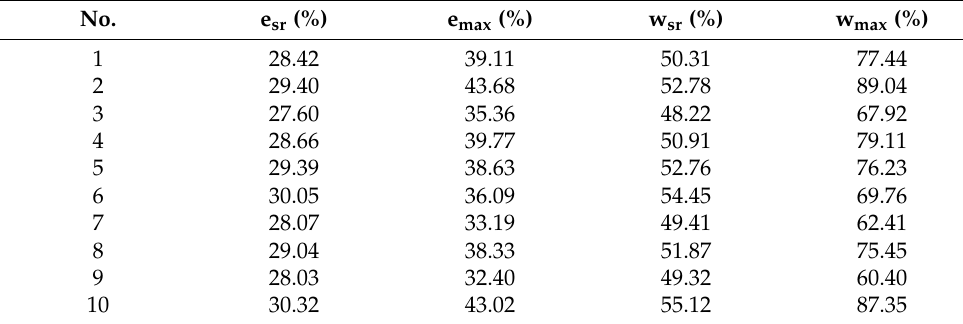
Table 2. Energy consumption and conveyor load divided into individual tests.